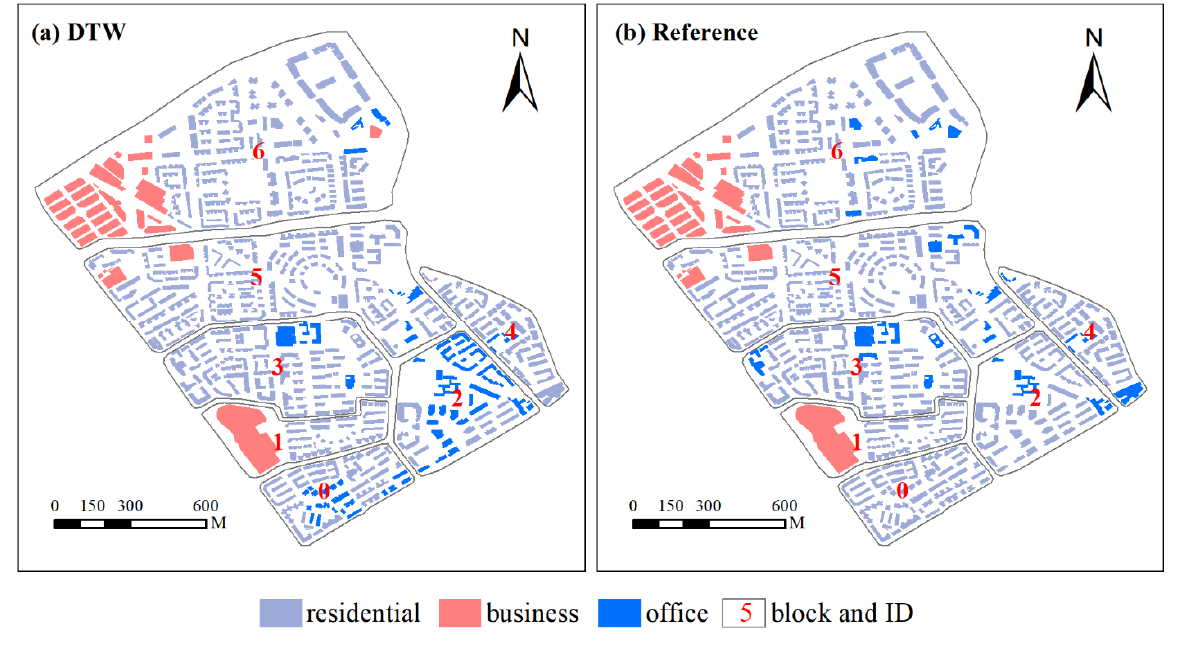
Figure 8. Results of building function recognition are shown for ( a ) DTW method, and ( b ) refer- ence